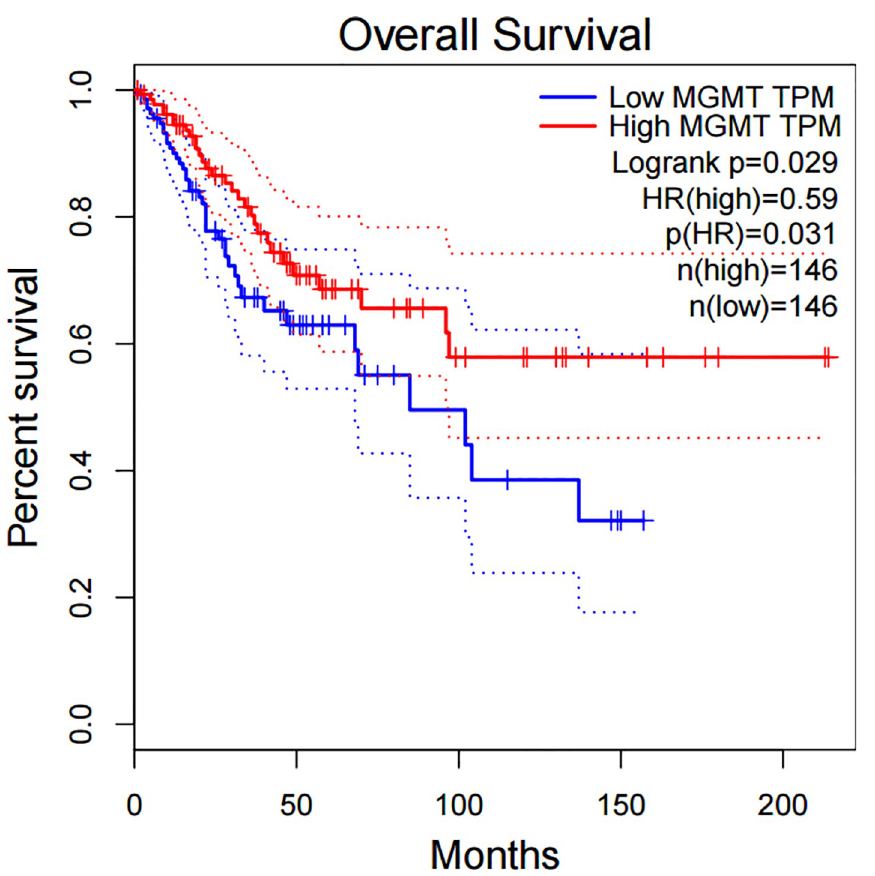
Fig 7. The correlation between MGMT expression and overall survival in cervical cancer ( p < 0.05) from GEPIA